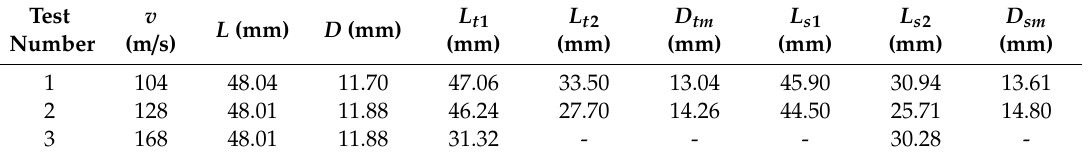
Table 3. Specific conditions of tests and simulations for several Taylor impact.